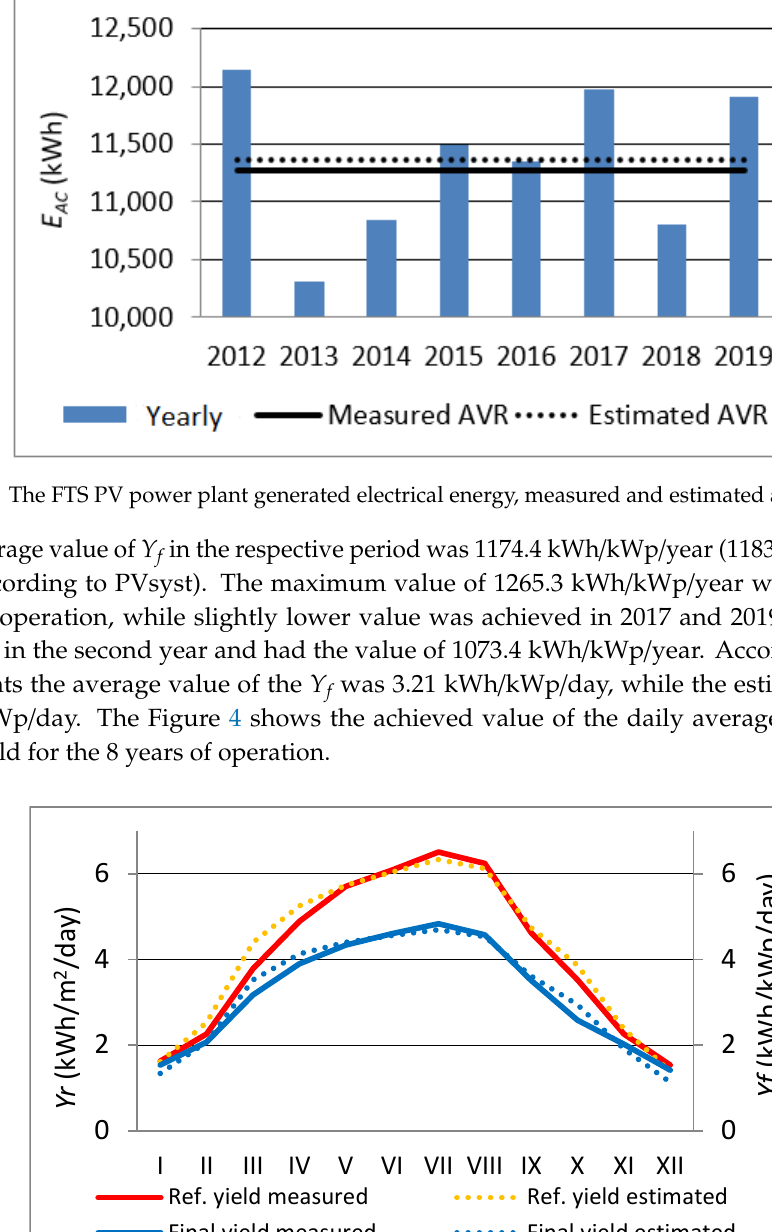
Figure 3. The FTS PV power plant generated electrical energy, measured and estimated average value.